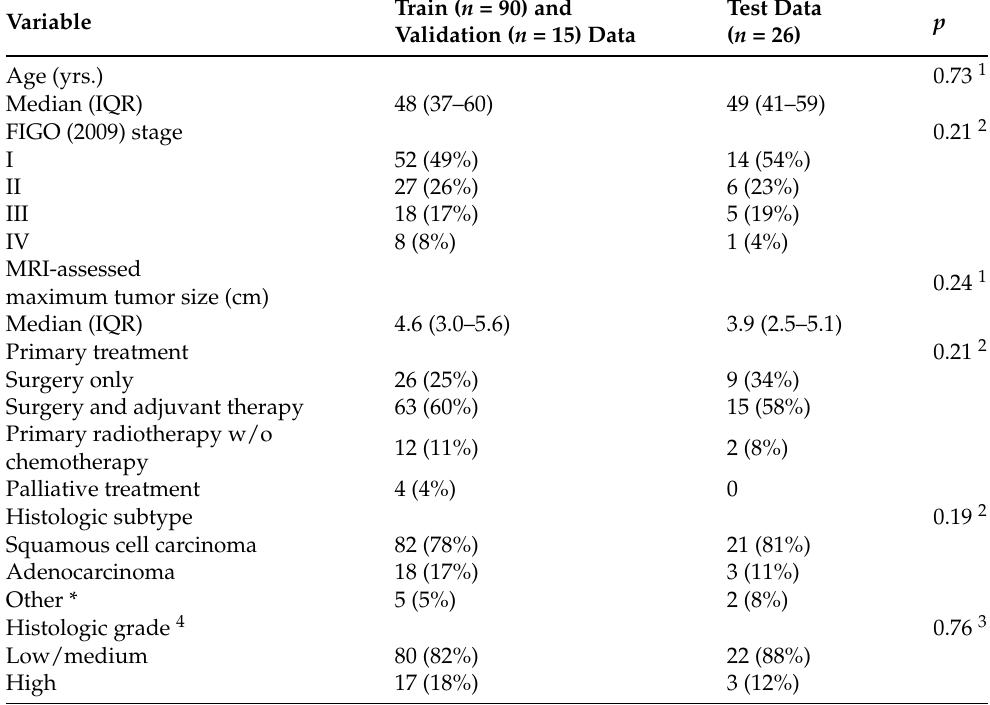
Table 2. Patient characteristics of the training/validation cohort ( n = 105) and the test cohort ( n = 26). The two patient cohorts have similar clinicopathological characteristics. 1 Mann–Whitney U test. 2 Pearson’s chi-square test. 3 Fisher exact test. 4 n = 97 for training/validation cohort and n = 25 for the test cohort. * Adenosquamous, neuroendocrine, and undifferentiated carcino- mas; FIGO = International Federation of Gynecology and Obstetrics; IQR = Interquartile range; w/o = with and